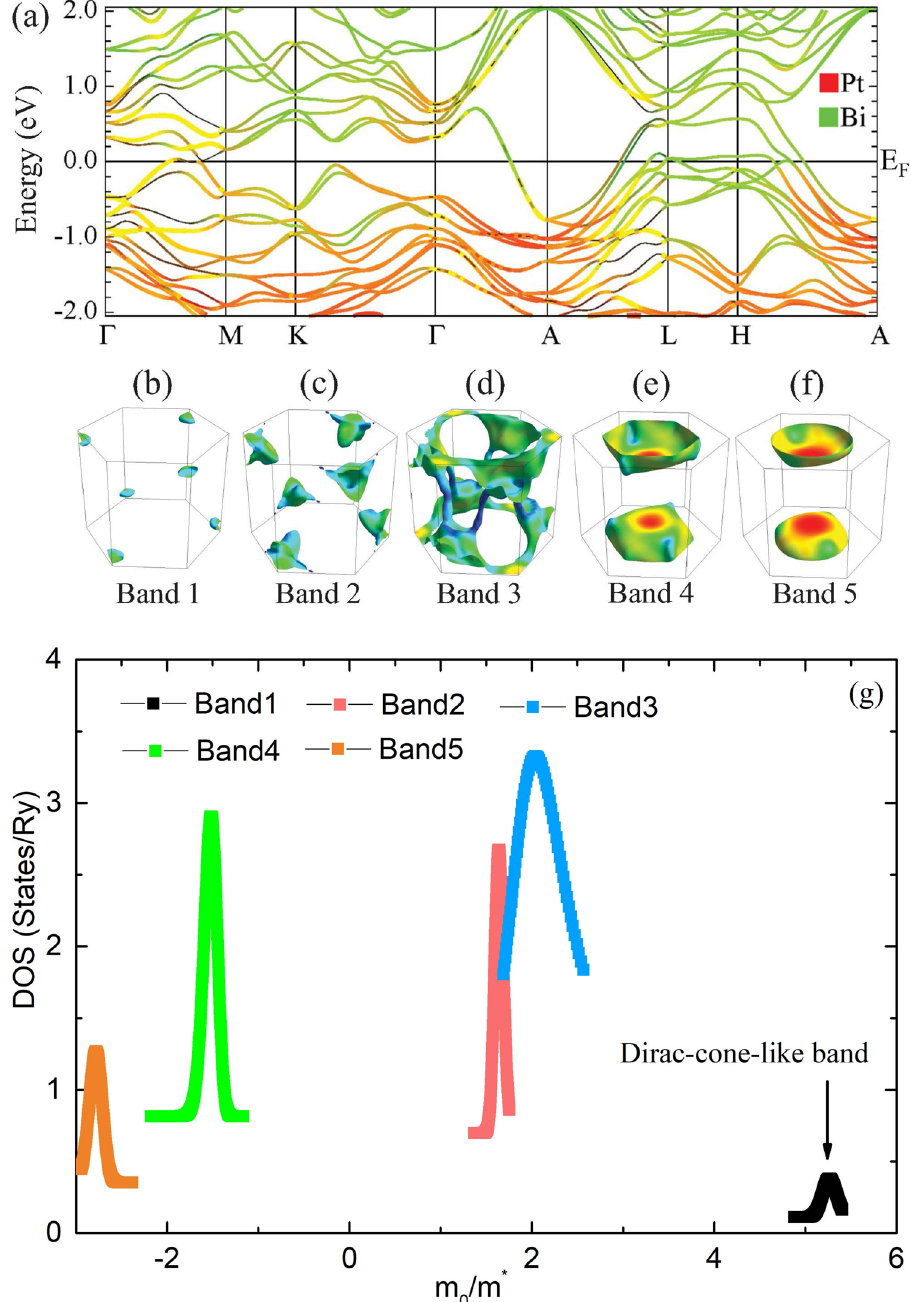
Pt- d orbital contributions, respectively. ( b – f ) Three-dimensional Fermi surfaces of PtBi 2 for each band in